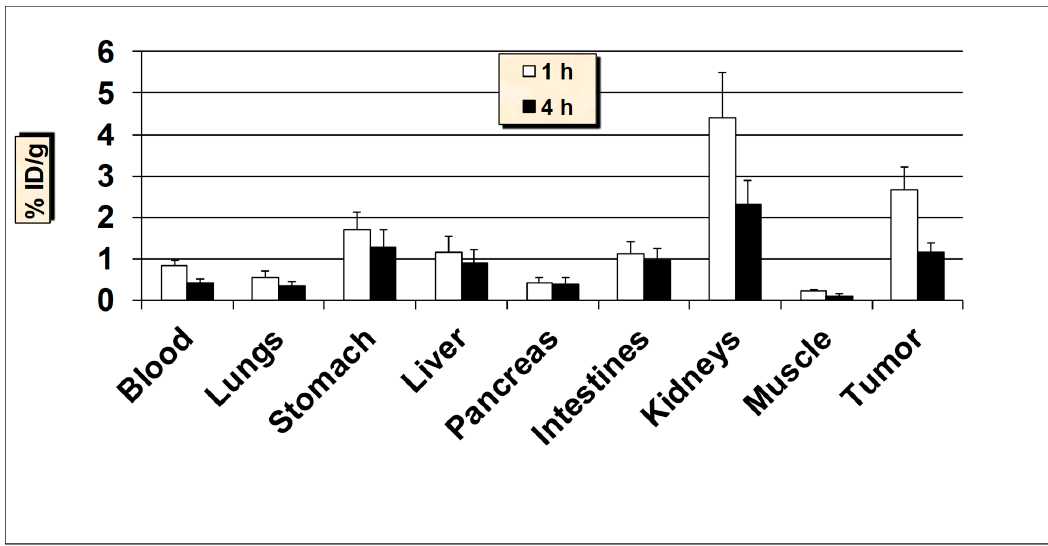
Figure 13. In vivo tumor targeting of 99m Tc-MUC1-derived peptide in MUC1-positive T47D tumor bearing female nude mice at 1 and 4 h post-injection. Data are expressed as % injected dose per gram (% ID/g) of tissue/organ (n = 3, mean values ± SD). Parts of the intestines were measured without their